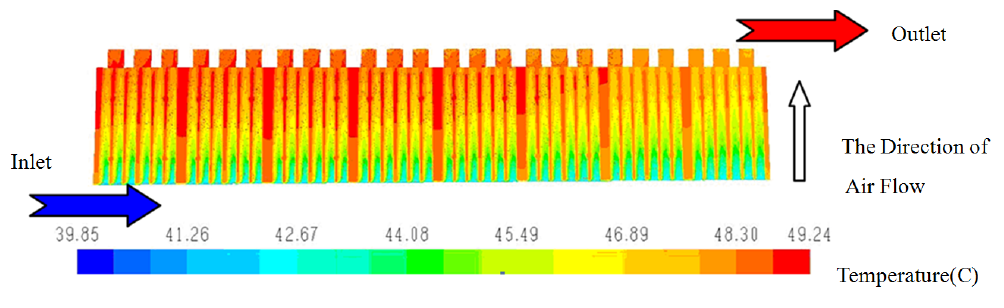
Figure 15. Temperature field of the first row of cells in the enhanced pack